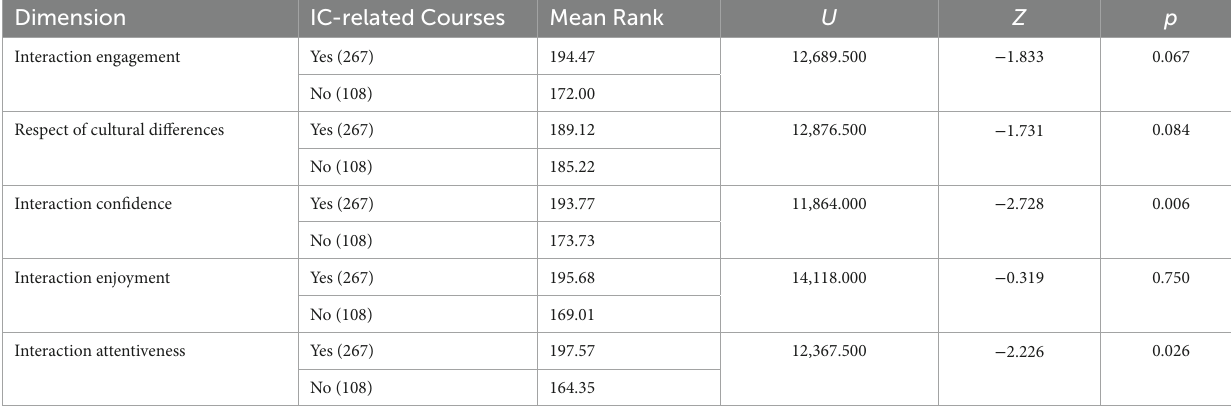
TABLE 5 Mann–Whitney U test for different dimensions according to whether one has taken the IC-related courses. Dimension